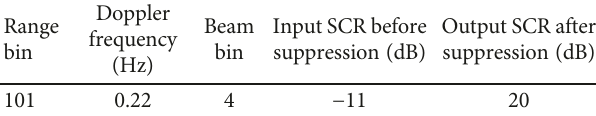
Table 2: Injected target